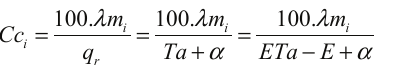
the program Table Curve 2D ® , version